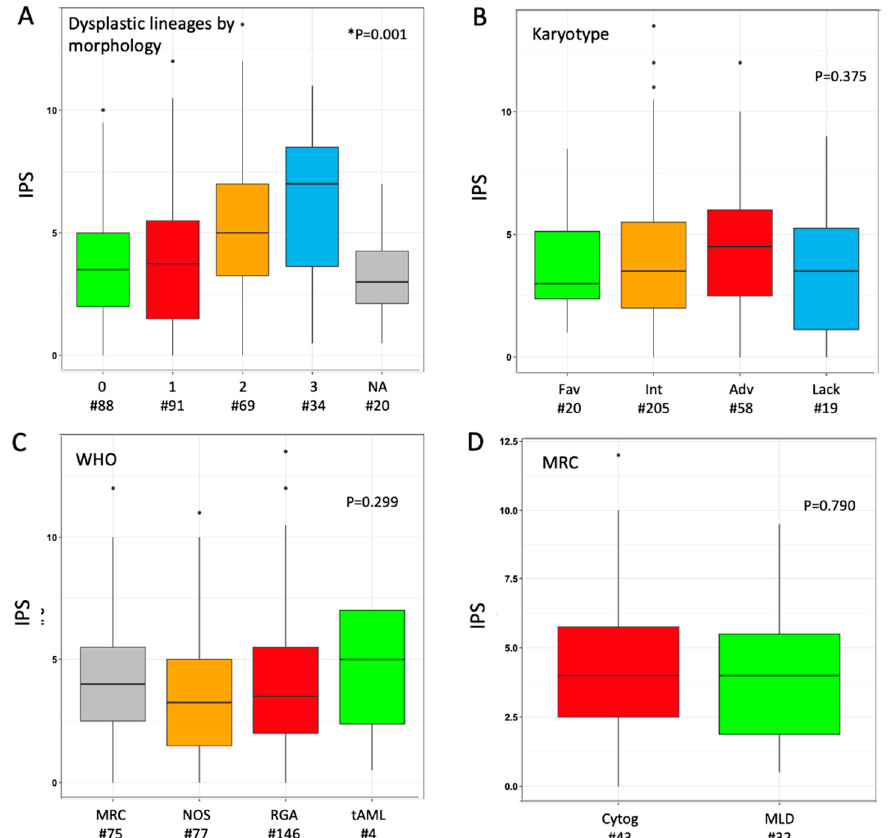
Figure 1. Distribution of immunophenotypic score (IPS) according to disease categorization. Box plot diagrams display the distribution of IPS values according to ( A ) number of dysplastic cell lineages by morphology, ( B ) karyotype risk, ( C ) WHO subset, ( D ) criterion for assignment to AML-MRC (either cytogenetic or morphological). Boxes represent the interquartile range that contains 50% of the cases, the horizontal line in the box marks the median. Dots are outliers. Comparisons were carried out by Mann–Whitney or Kruskal–Wallis or test (depending on number of categories, either two or more). * In panel ( A ), twenty cases were not assessable (NA) for any of the three cell lineages by morphology; in this analysis, Kruskal–Wallis test was carried out excluding NA cases. Abbreviations: IPS, immune-phenotypic score; Fav, favorable; Int, intermediate; Adv, adverse; Lack, lack of growth; WHO, World Health Organization; MRC, myelodysplasia-related changes; NOS, not otherwise specified; RGA, recurrent genetic abnormalities; tAML, therapy-related AML; Cytog, defined by MDS-related cytogenetic abnormality; MLD, defined by multilineage dysplasia at morphology; wt, wild